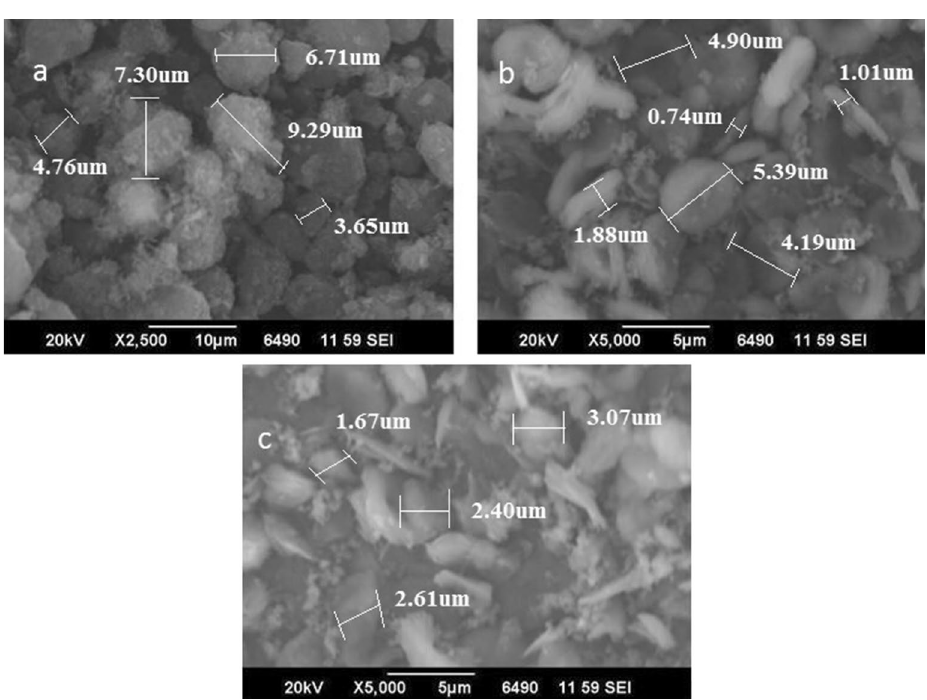
Figure 3. SEM image of MCM-22 ( a ), H-MCM-22 20% ( b ) and ITQ-2 ( c